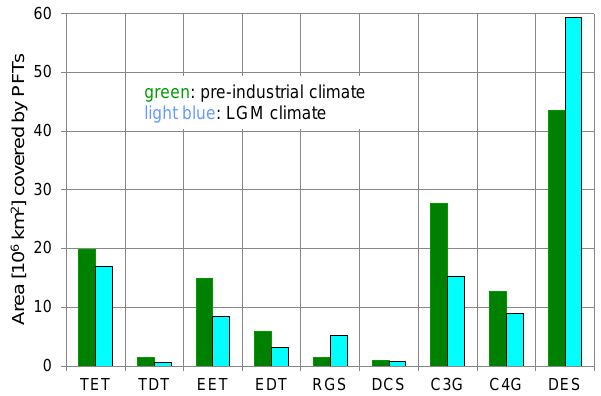
Fig. 4. Area (in 10 6 km 2 ) covered by different PFTs and bare ground for pre-industrial climate (dark green columns) and glacial climate (blue columns). The PFTs are tropical evergreen trees (TET), tropical deciduous trees (TDT), extratropical evergreen trees (EET), extratropical deciduous trees (EDT), raingreen shrubs (RGS), deciduous shrubs (DCS), C3 grass (C3G), C4 grass (C4G), and bare ground